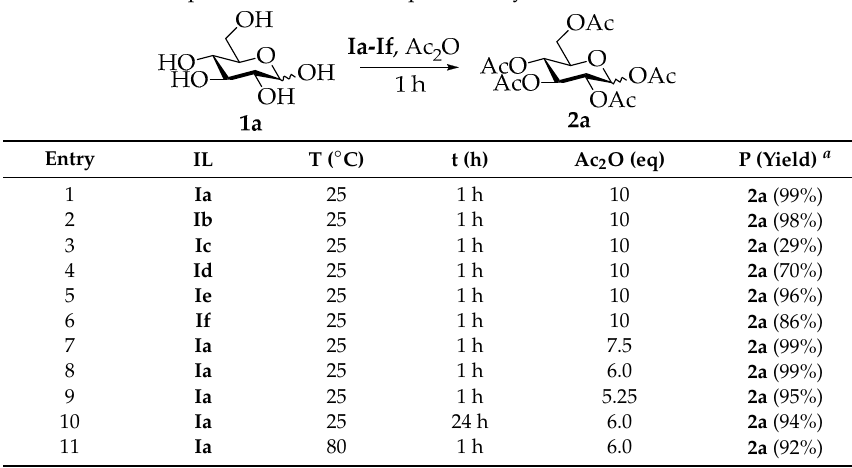
Table 1. Optimized condition of per- O -acetylation without solvent.